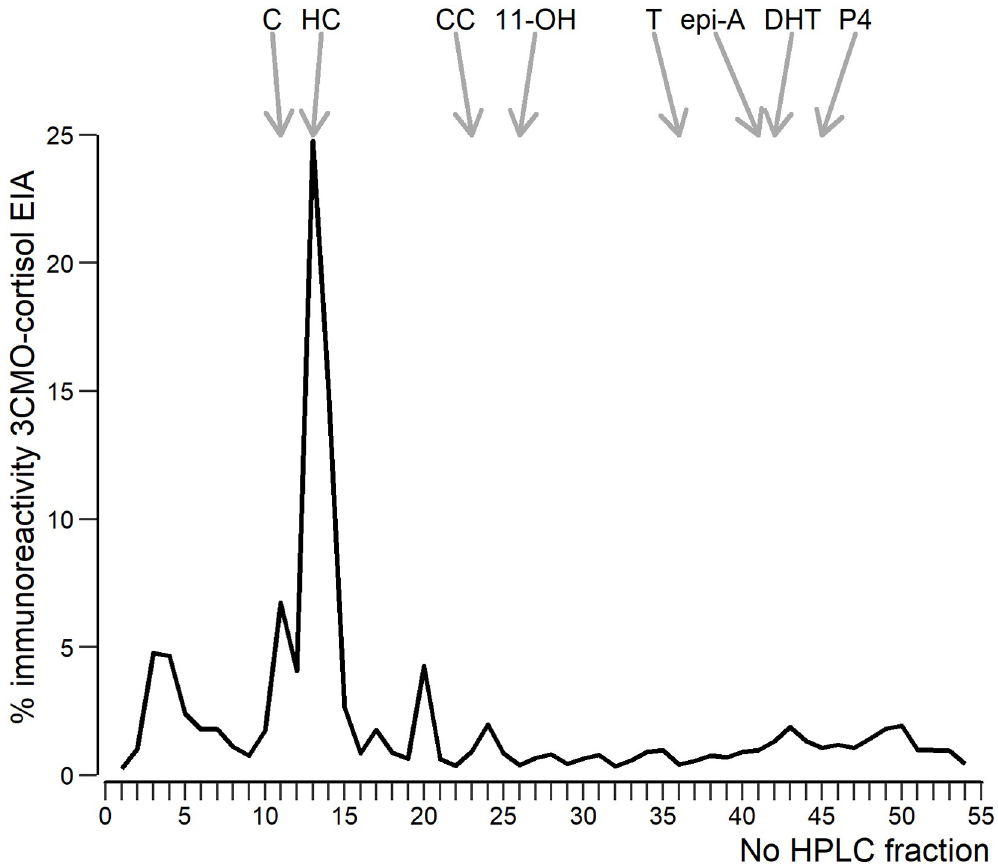
Fig 1. High performance liquid chromatography (reversed phase) separations of immunoreactive cortisol metabolites in pooled hair samples from Egyptian mongoose. The obtained fractions were analysed with a cortisol-3-CMO EIA. The elution positions of reference standards are indicated by arrows: 11: C (cortisone); 13/14: HC (cortisol); 23: CC (corticosterone); 26: 11-OH (11-hydroxyetiocholanolone); 36/37: T (testosterone); 41: epi-A (epi-androsterone); 42: DHT (dihydrotestosterone); 45: P4